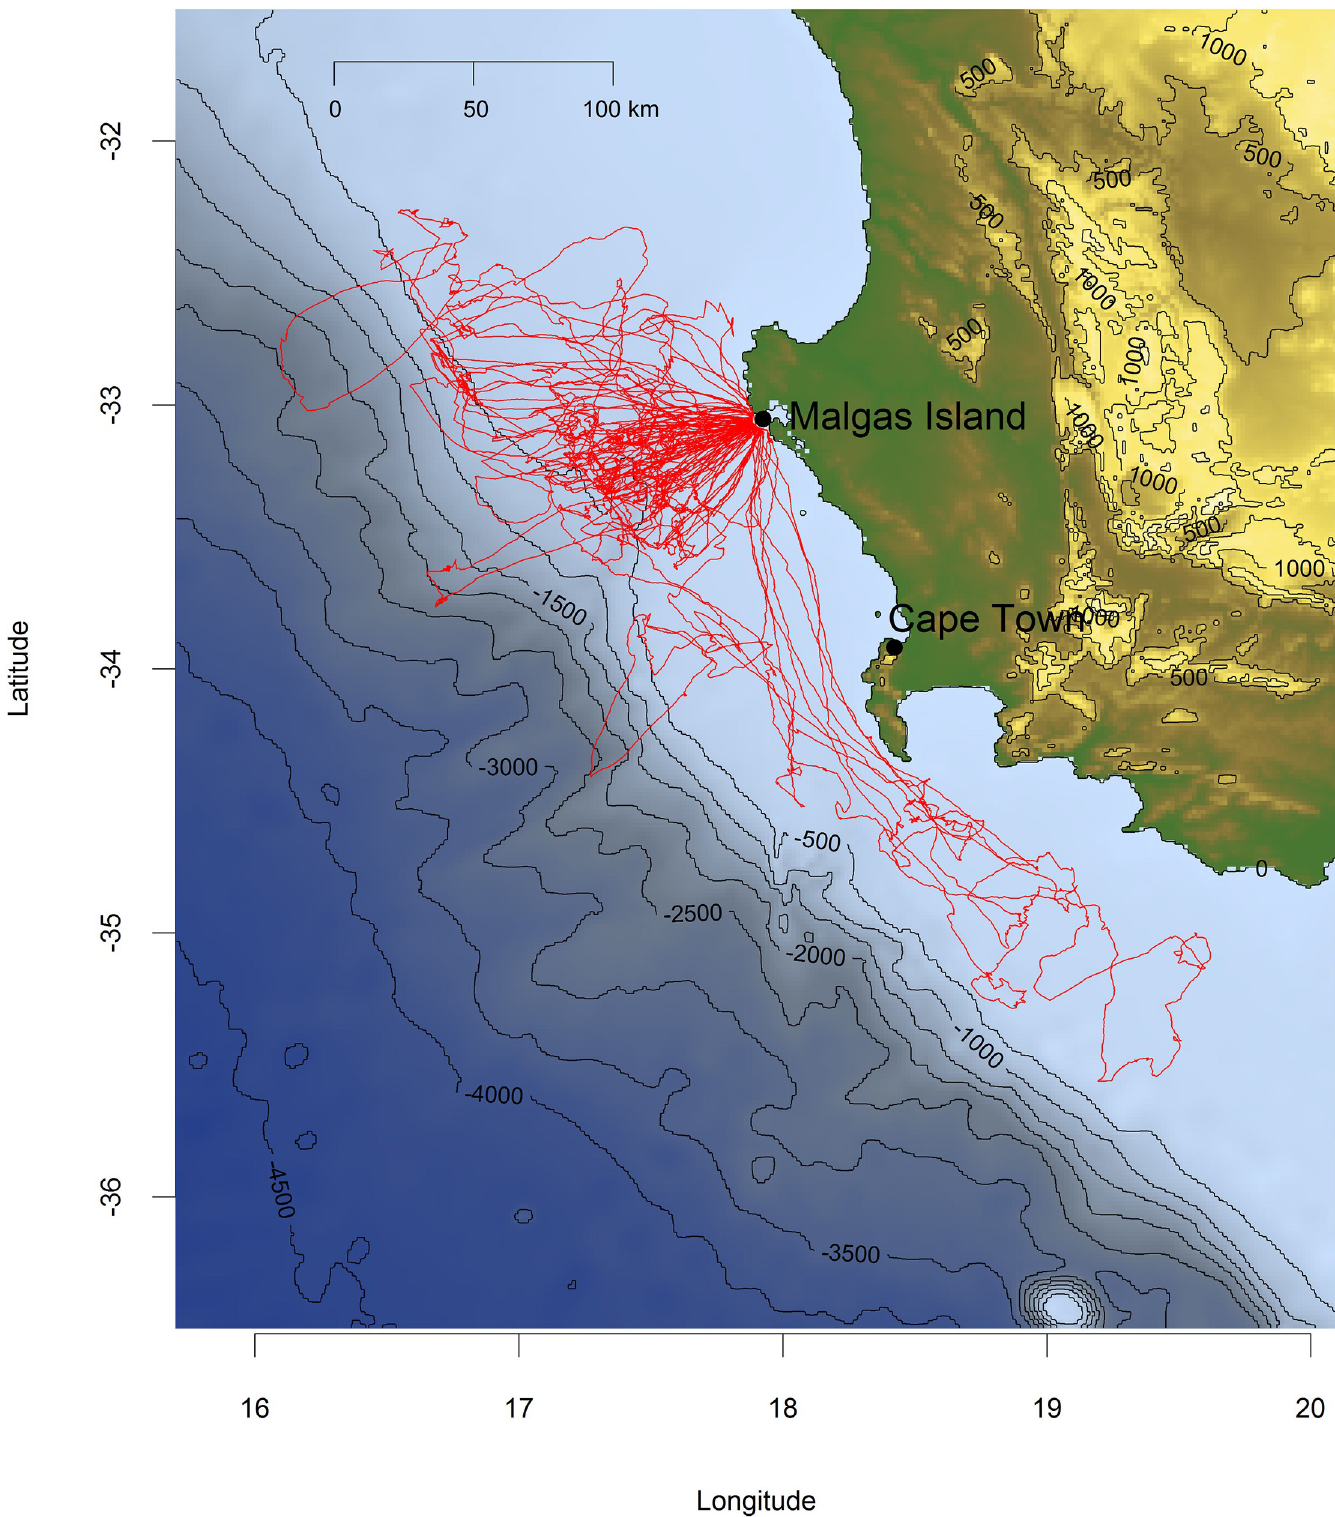
Fig 3. Foraging tracks of 50 Cape gannets provisioning for small chicks from the Malgas Island breeding colony in the southern Benguela upwelling region in 2017. Blue shades indicate bathymetry (R package marmap).